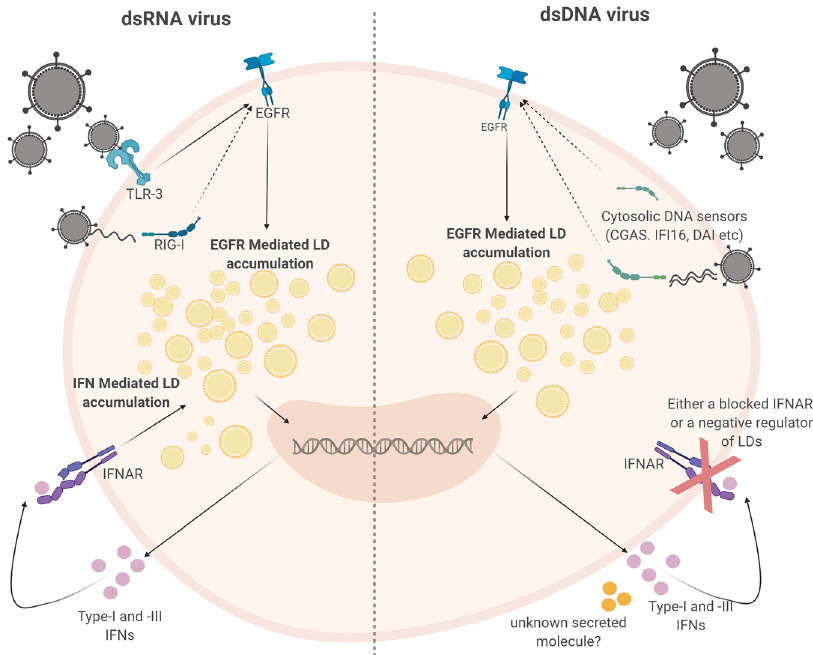
Fig. 9 Lipid droplets are induced to enhance an effective interferon response. Here we demonstrate that the host upregulates LDs following pathogen detection in two waves. The fi rst wave is EGFR dependent which is independent of interferon production, and the second wave is induced via interferon production. During dsDNA stimulation, there is no second wave, and this is hypothesised to be due to a negative regulator of LD accumulation produced by cells during this response. Figure created by authors on